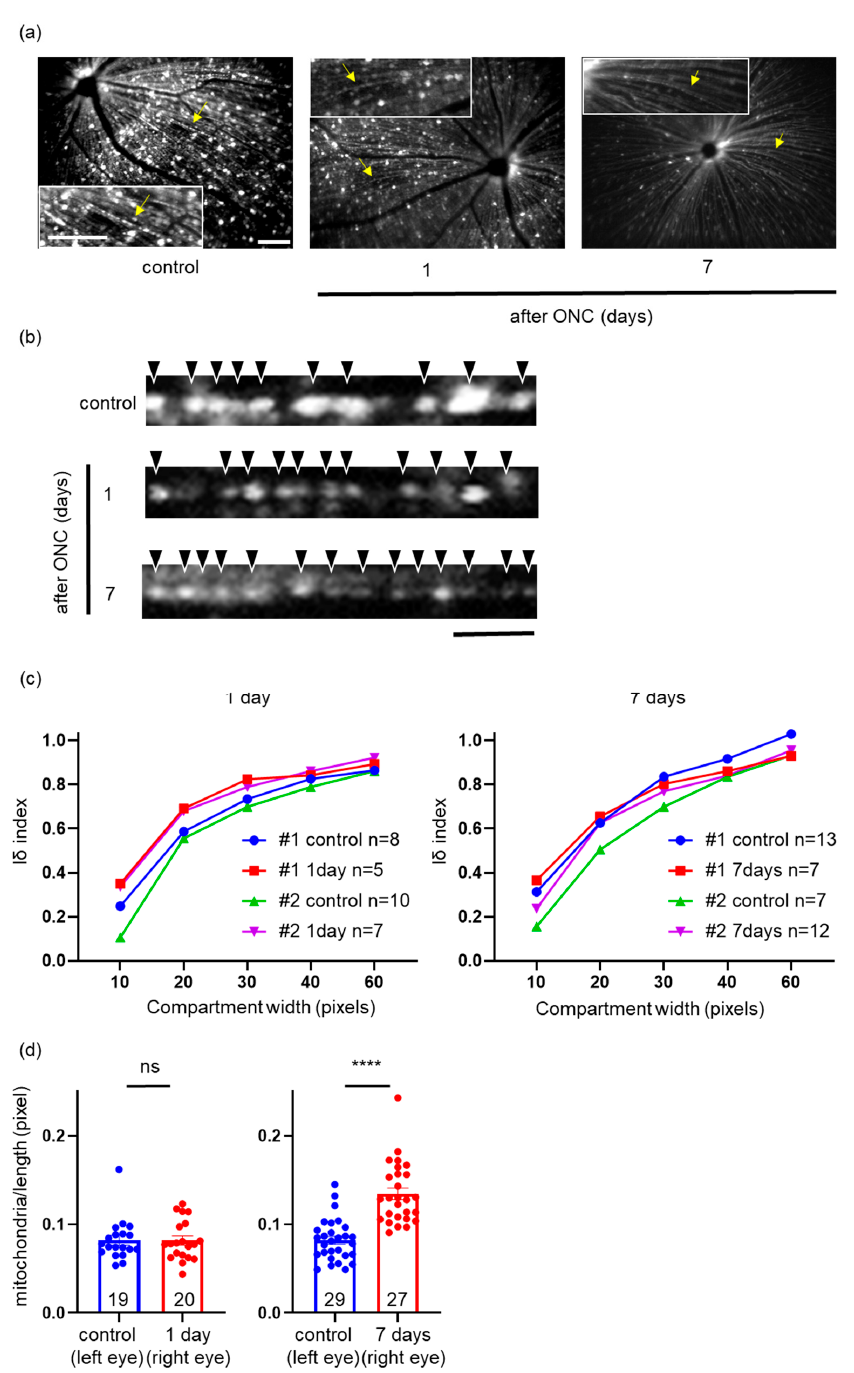
Figure 5. In vivo cSLO imaging of mitochondria within a single axon and mitochondrial distribution. ( a ) The original fundus images of yellow fluorescent protein. Enlarged images are provided in the insets. Yellow arrows indicate the analyzed axons in ( b ). Mitochondria (YFP) shown in white. Bars, 100 pixels. ( b ) Mitochondria visualized within a linearized axon captured with a cSLO. Black arrowheads indicate individual mitochondria. Mitochondria (YFP) shown in white. Bar, 20 pixels. cSLO: confocal scanning laser ophthalmoscope; ONC: optic nerve crush. ( c ) Plotting of the I δ index against compartment width. All the graphs indicate that the mitochondrial distribution was uniform. Two different mice (#1 and #2) were used and the number of axons used for quantification is indicated in the graph. Note that the axons clearly visualized at longer than 120 pixels in length could be analyzed. ( d ) The average density of mitochondria in the axons. The number of axons used for quantification is indicated in the graph. Data are presented as the mean ± SEM. **** p < 0.0001, ns = not